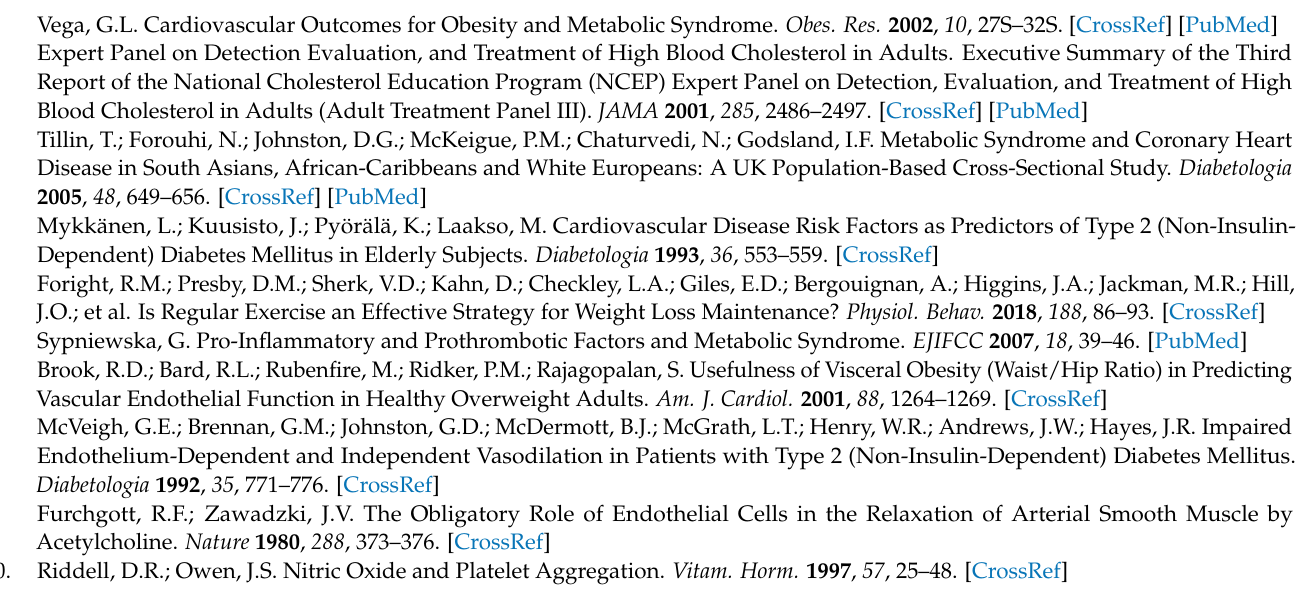
extract; Table S2: Details of the 16-week aqua exercise program for older women with metabolic syndrome; Table S3: Descriptive characteristics of the study participants; Table S4: Effects of the 16-week aqua exercise on blood pressure and insulin resistance in older women with metabolic syndrome; Table S5: Changes in blood pressure and insulin resistance after the 16-week aqua exercise in older women with metabolic syndrome; Table S6: Effects of the 16-week aqua exercise on vascular regulation factors in older women with metabolic syndrome; Table S7: Changes in the vascular regulation factors after the 16-week aqua exercise in older women with metabolic syndrome; Table S8: Effects of the 16-week aqua exercise on arterial stiffness in older women with metabolic syndrome; Table S9: Changes in arterial stiffness after the 16-week aqua exercise in older women with metabolic syndrome; Table S10: Correlation between delta ( ∆ )